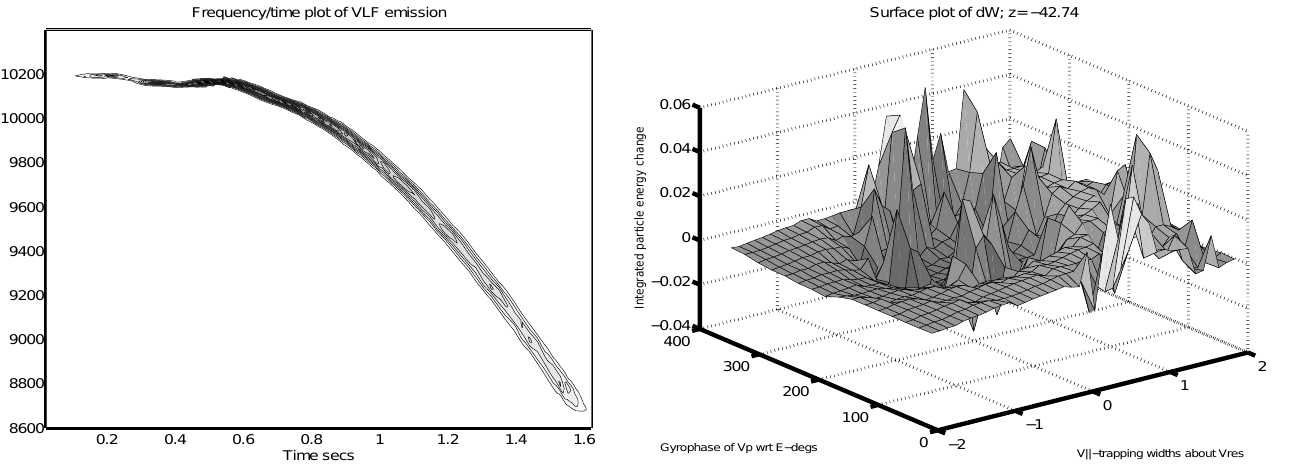
Fig. 15. Run 2. Surface plot of dW, the integrated particle energy change in dimensionless units, in the V ∗ ,ψ plane, for the | V ⊥ | beam with a pitch angle of 71 degrees; recorded at t = 1 . 0s and at z = − 42 . 7km (on the ground TX side). The stably trapped particles in the “trap” correspond to the large positive values of dW. The gyrophase ψ is the phase of the V ⊥ vector relative to wave electric field.